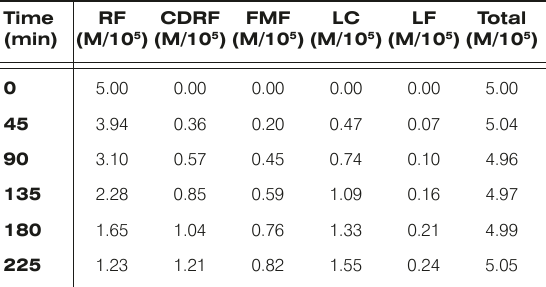
Table 3. Photolysis of 5×10 –5 M RF solution in the presence of 1.0 M phosphate buffer at pH 7.0 [57]. Time